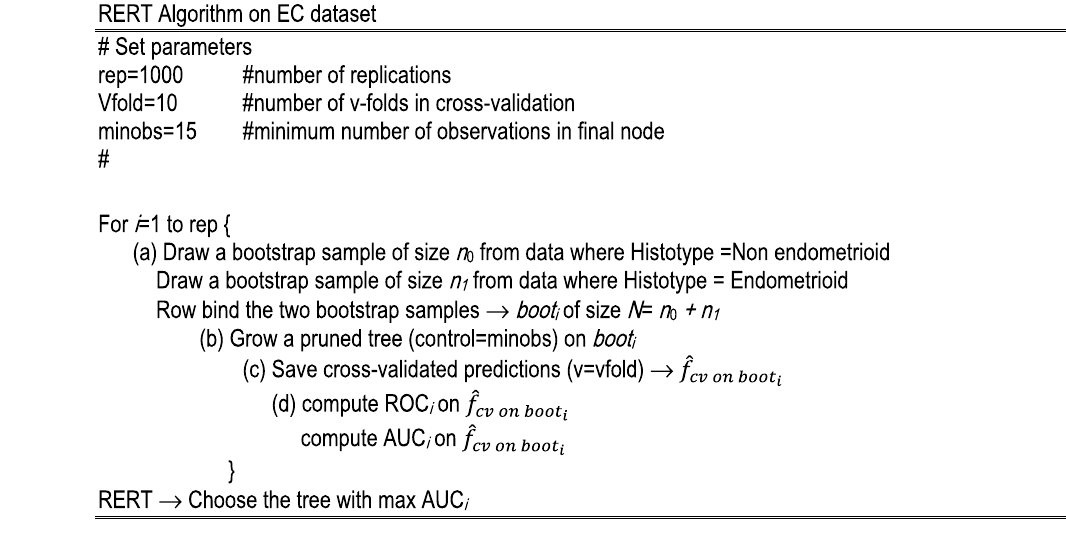
the results across multiple replications. Specifically: ( i ) we drew 1000 bootstrap samples from the original data set, stratifying according to histotype; ( ii ) in each sample we grew a tree, and ( iii ) among these 1000 different trees, we selected the best performer in terms of Area Under the Curve (AUC) of the Receiver Operator Characteristic (ROC) curve: this tree is our REpresentative Regression Tree (RERT; see below for technical